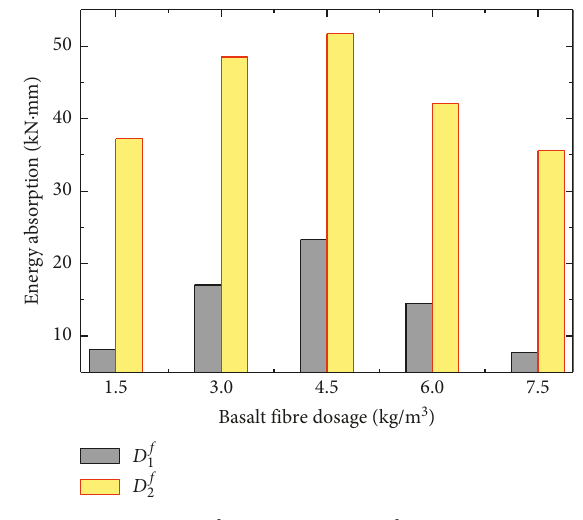
Figure 4: Residual flexural strength after failure.